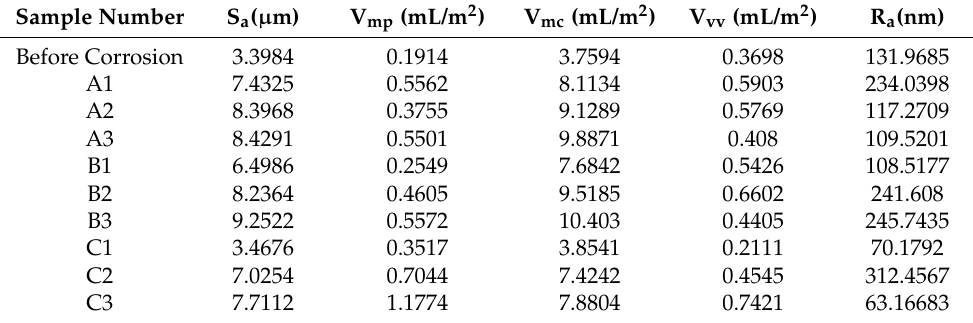
Table 5 . Roughness Data .